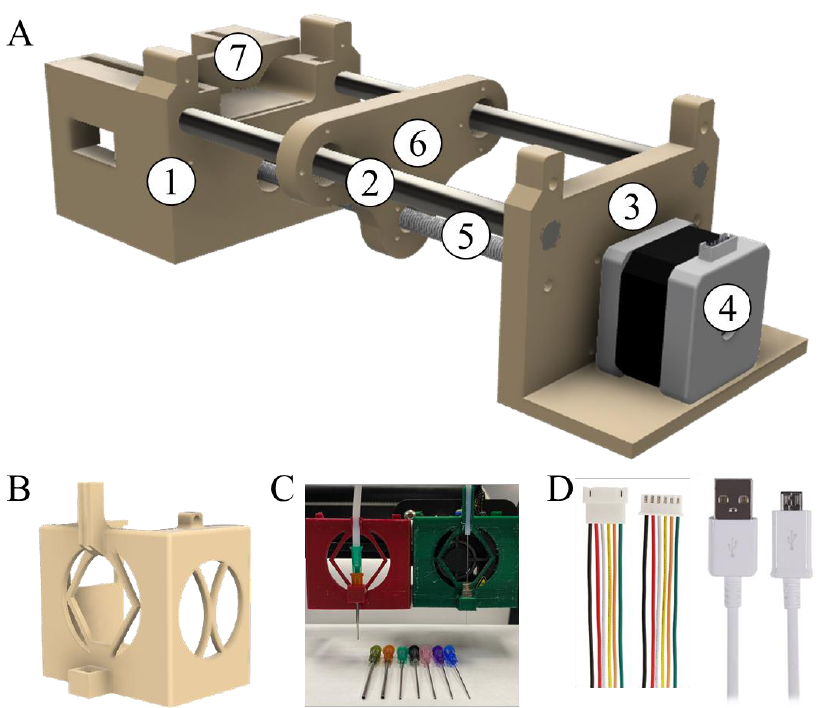
Figure 2. Modification parts, both engineered and commercially available, to reequip a standard 3D printer to deal with liquid and gelled inks. ( A ). Plunger supply system: FDM parts of construction: 1, 3 — construction holders, 6, 7 — pusher and syringe holder; CNC parts: 2 — 8 mm guide rails, 4 — Nema 17 stepper motor, 5 — lead screw rod. Metal locks and bearings are omitted for visualization simplicity. ( B ). Printed holder of needle and tube (nozzle holder), ( C ). Examples of tube connection of different inner and outer diameter, ( D ). Wire connections of printer with stepper and printer with laptop (Figure 1B, c,d). Note: the printer is not to be used in autonomous mode, as this could poten-